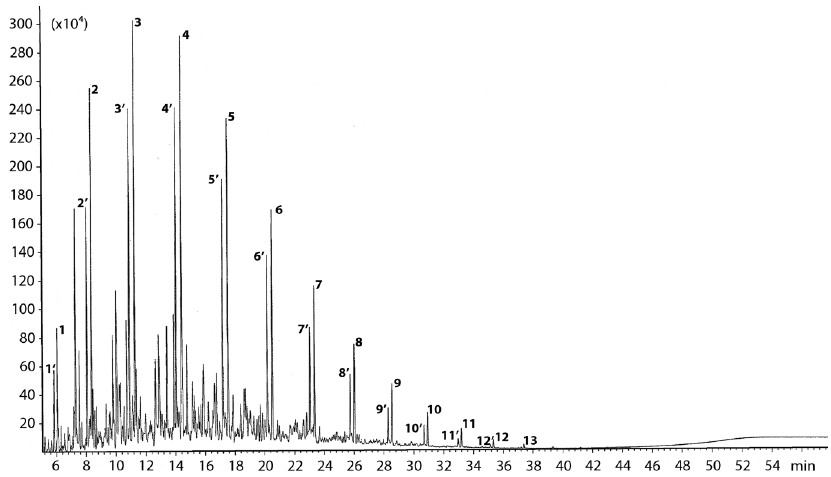
Fig. 1. A GC-MS chromatogram of the light distillate (t° Table 5. Aliphatic hydrocarbons of the light distillate, wt% Peak No